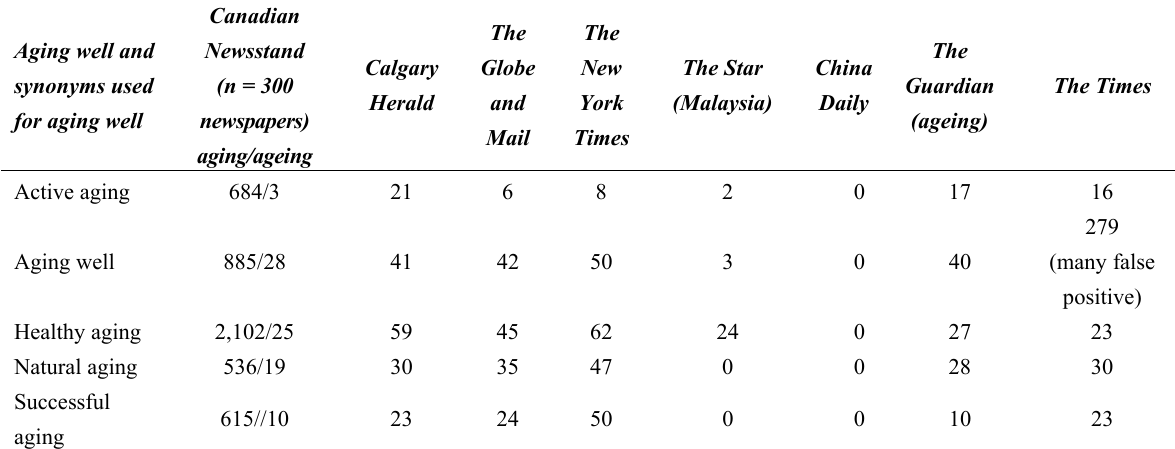
Table 1. Frequency of occurrence of aging well related terms (active aging; aging well; healthy aging; natural aging and successful aging) in the newspaper; for Canadian Newsstand we also searched with the spelling